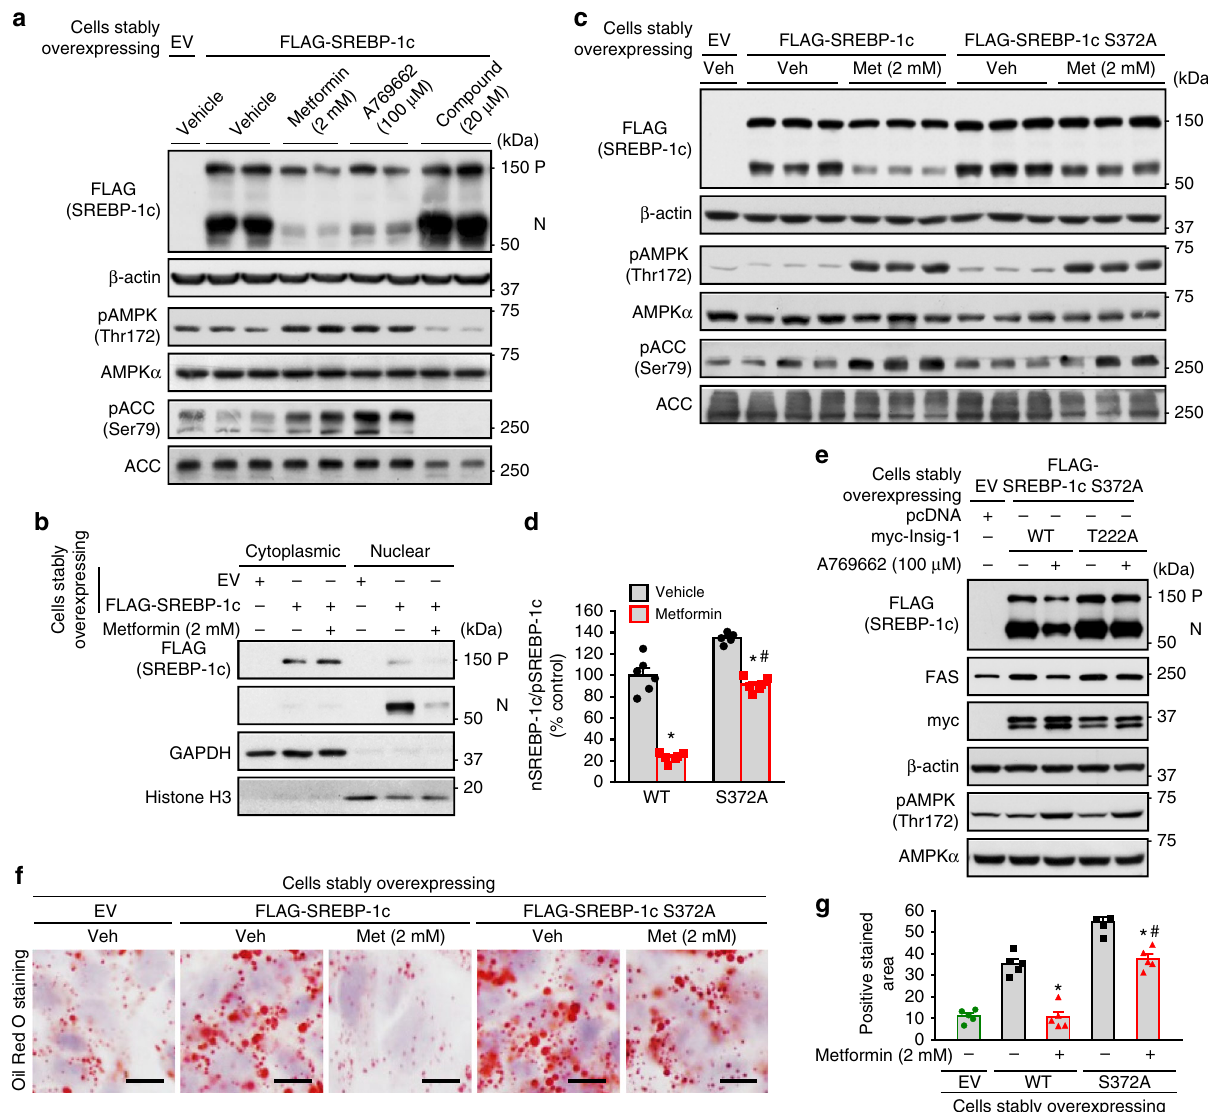
Fig. 6 SREBP-1c S372A mutant stably expressed in human HepG2 cells remains responsive to AMPK-inhibited proteolytic cleavage. a The cleavage processing of exogenously wild-type (WT) SREBP-1c stably expressed in human HepG2 hepatocytes is sensitive to the treatment of AMPK agonists or inhibitor. HepG2 cells stably expressing FLAG-tagged SREBP-1c were treated with 2 mM metformin for 24 h, 100 μ M A769662 for 8 h, or 20 μ M compound C for 24 h. Immunoblots were performed, and the precursor and active nuclear form of SREBP-1c was visualized using FLAG antibody. b The nuclear translocation of SREBP-1c is prevented by metformin. HepG2 cells stably expressing FLAG-tagged WT SREBP-1c were treated with 2 mM metformin for 24 h. Cellular fractionation was performed, followed by immunoblots to evaluate the levels of SREBP-1c in the cytoplasm and nucleus. c , d SREBP-1c S372A mutant stably expressed in human HepG2 cells remains responsive to AMPK agonist metformin-inhibited proteolytic cleavage. HepG2 cells stably expressing FLAG-tagged WT SREBP-1c or SREBP-1c S372 mutant were treated with 2 mM metformin for 24 h. Immunoblots were performed. e Thr222 phosphorylation of Insig-1 is required for the inhibition of SREBP-1c cleavage and lipogenic gene expression by A769662. HepG2 cells stably expressing FLAG-tagged SREBP-1c S372 mutant were transfected with pcDNA or myc-tagged WT Insig-1 or T222A mutant for 24 h, and then treated with 100 μ M A769662 for 8 h. Immunoblots were performed. f , g SREBP-1c S372A mutant stably expressed in human HepG2 cells remains responsive to AMPK agonist metformin-inhibited lipid accumulation. Cells were treated with 2 mM metformin for 24 h. Representative oil red O staining ( f ) and the quanti fi cation of are shown ( g ). Scale bars, 10 μ m. Data are presented as the mean ± SEM, unpaired two-tailed Student ’ s t -test, n = 5 – 6, * p < 0.05, vs. WT; # p < 0.05, vs. SREBP-1c